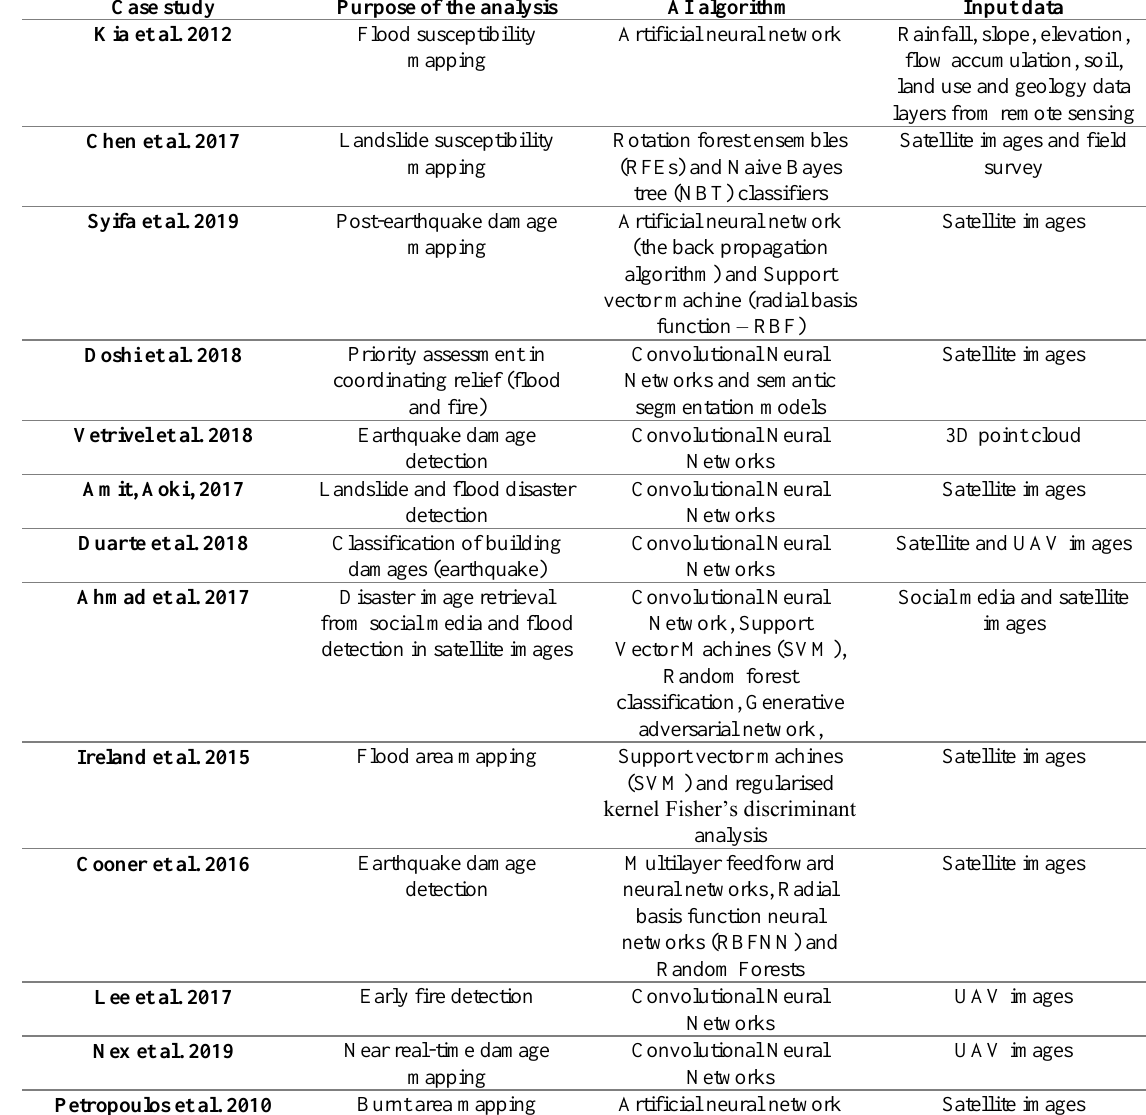
Table 1. Case studies that implement AI in geospatial analysis in disaster